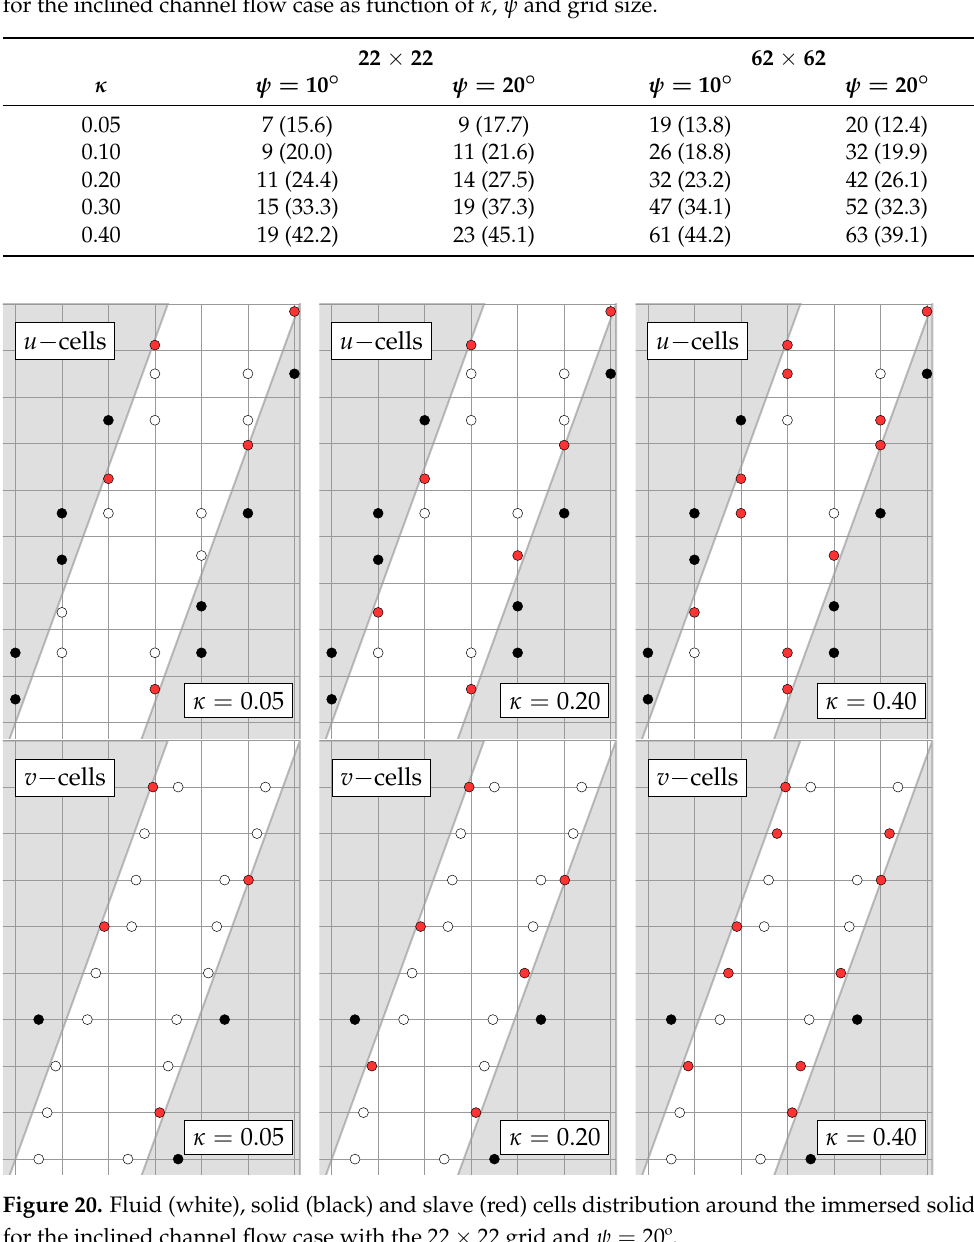
Table 3. Number of v slave cells generated and their percentage (in parenthesis) over total v cut cells for the inclined channel flow case as function of κ , ψ and grid size.